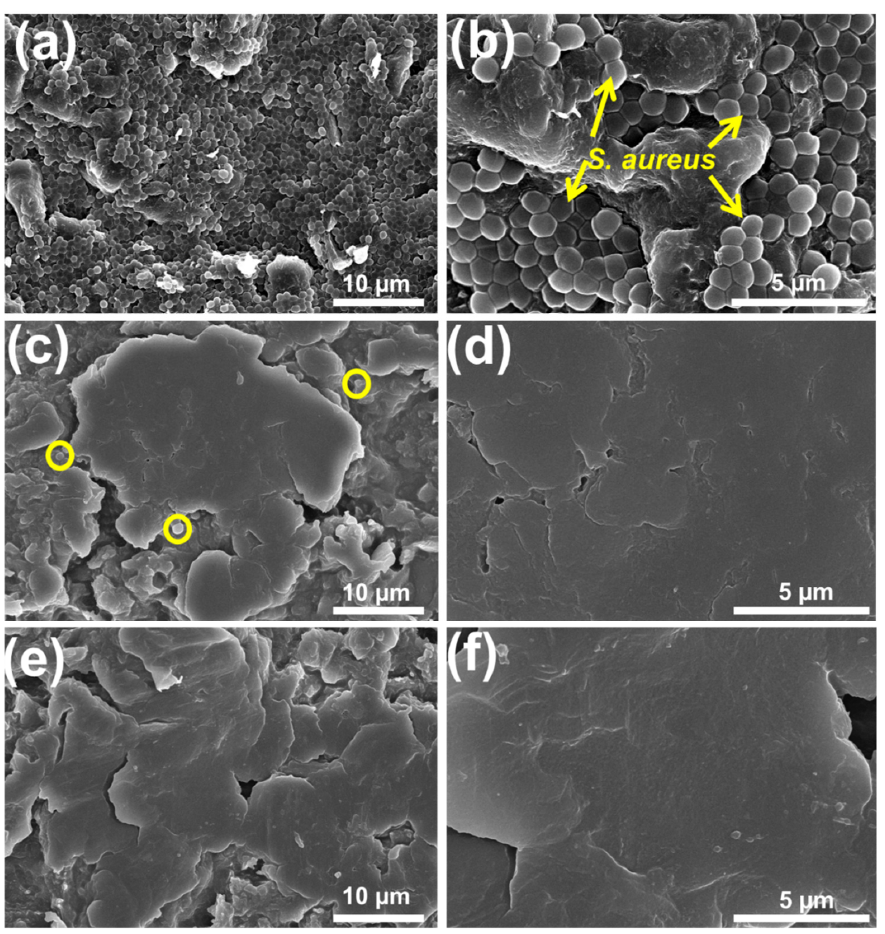
Figure 6. Low- and high-magnification FESEM micrographs of post-bacterial treatment using ( a , b ) PEEK, ( c , d ) PEEK/GL13K, and ( e , f ) PEEK/GL13K-EDC